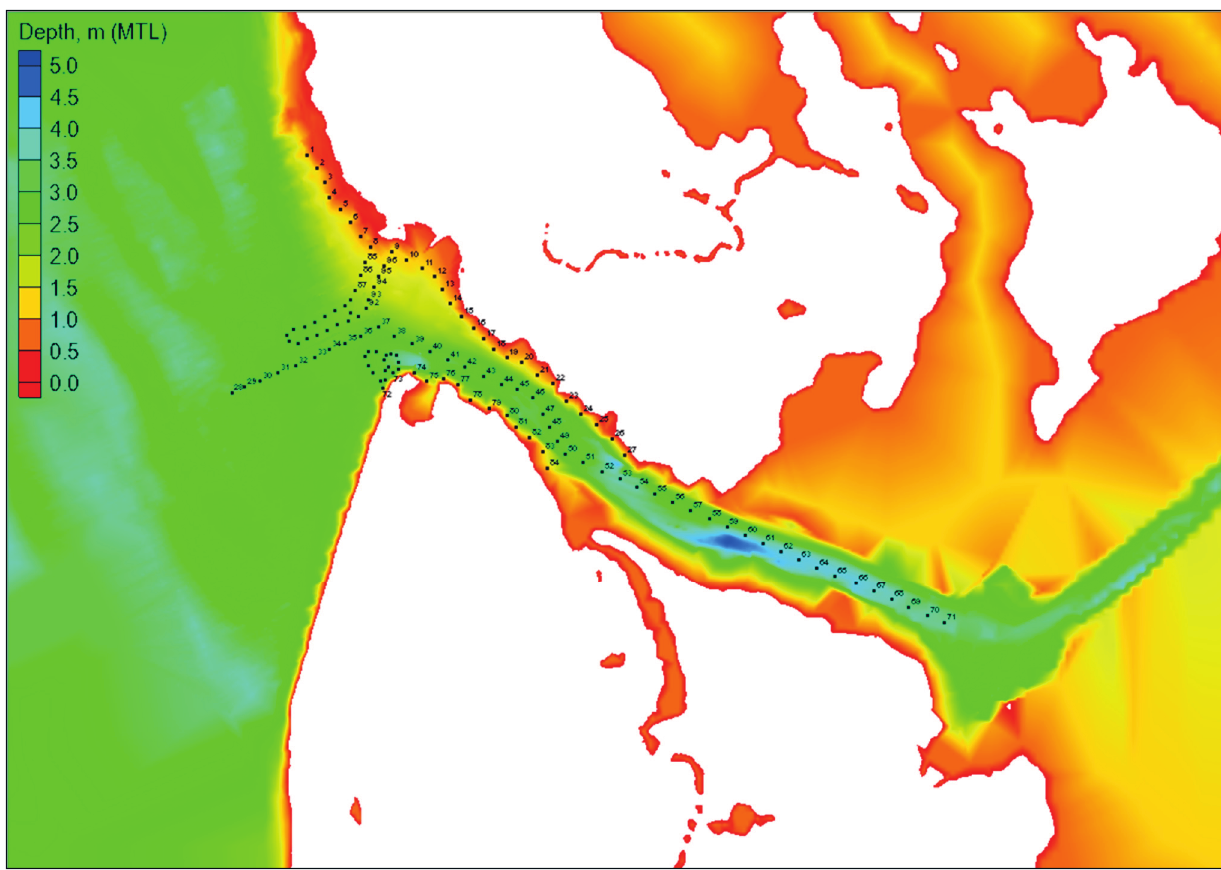
Figure 18. Point locations (stations) used to extract model wave